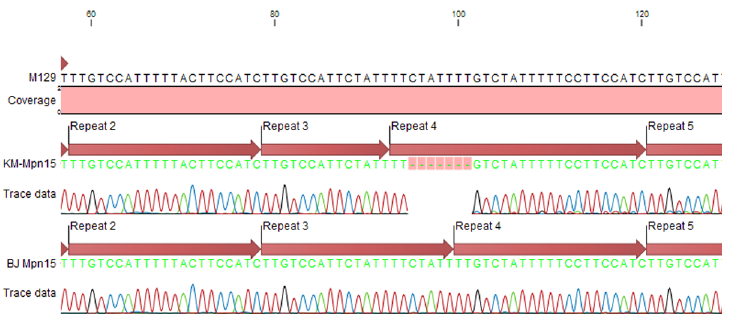
Fig 3. Sequence comparison of the locus Mpn 15. M129, M . pneumoniae reference strain; KM-Mpn15, the special sequence of Mpn15 from Kunming; BJ-Mpn15, the normal sequence of Mpn15 from Beijing; all repeat sequences in Mpn15 were 21-bp-long, except repeat 3, which was a 14-bp-long truncated sequence.